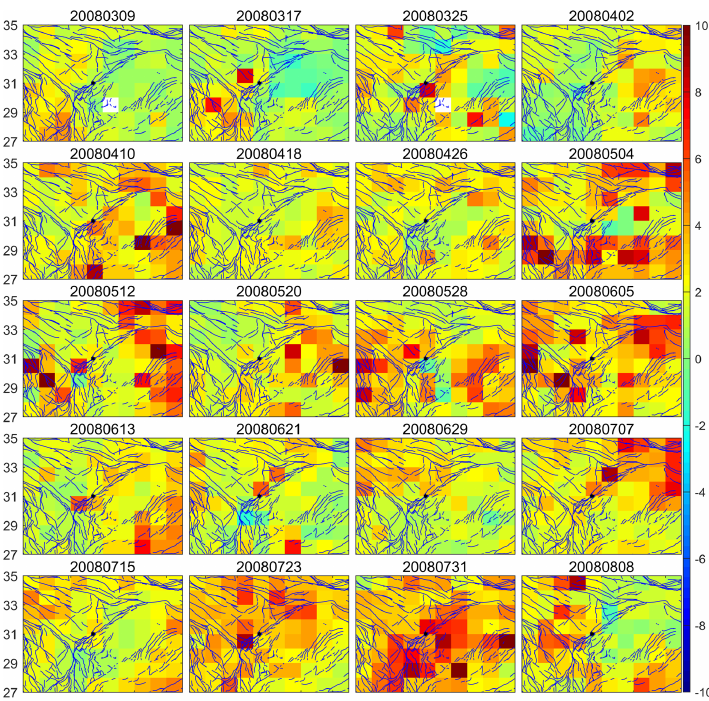
Figure 6. ALICE index of 8d CH 4 VMR at